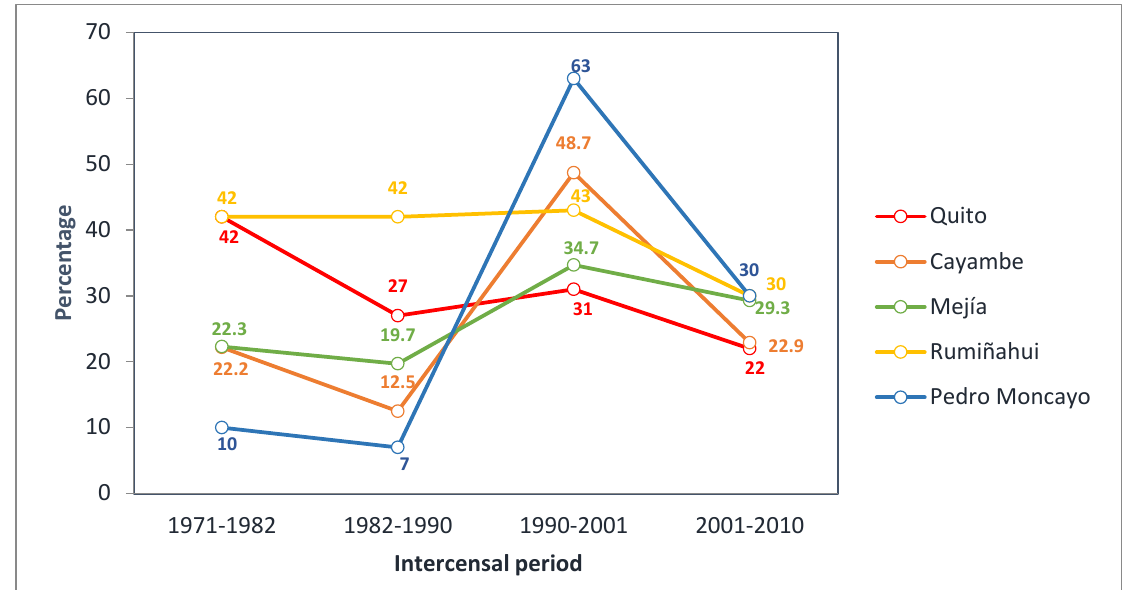
Figure 5. Population growth rate per canton 1971 – 2010.